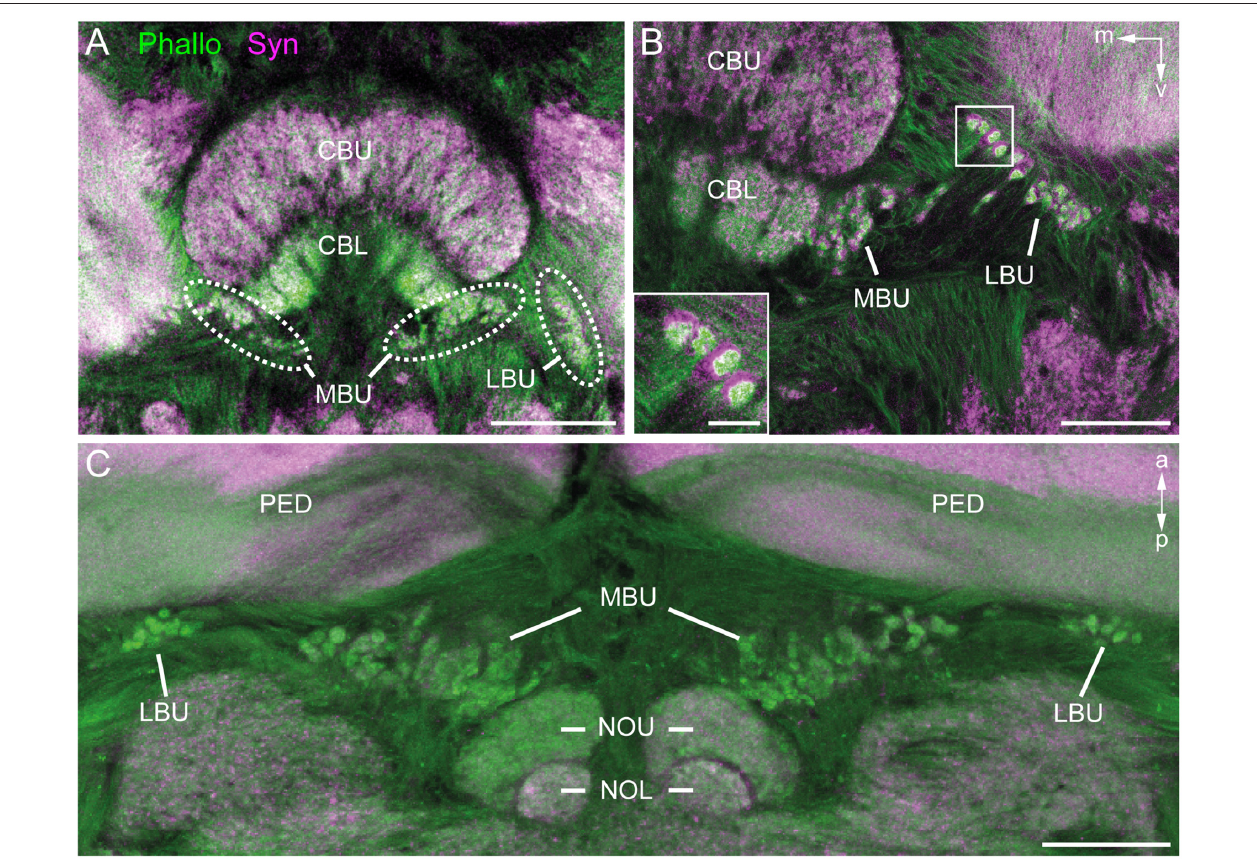
FIGURE 2 | Anti-synapsin (Syn, magenta) and f-actin phalloidin (Phallo, green) staining of the microglomerular synaptic complexes. (A) Frontal sections show that the synaptic complexes are arranged in two clusters: one in the MBU close to the connection of the CBL and the upper division (CBU). The second cluster is located in the LBU. (B) At higher magnification of both clusters the distribution of the anti-synapsin and f-actin phalloidin staining reveals a synapsin-positive cup-shaped structure with an f-actin containing profile in the center. (C) In horizontal sections the distribution in the anterior-posterior axis becomes apparent. The synaptic complexes in both bulbs appear posterior to the pedunculi (PED). Those of the MBU extend posterior to the upper division of the noduli (NOU). a, anterior; m, medial; NOL, lower division of the noduli; p, posterior; v, ventral. Scale bars: A = 100 µ m, B,C = 50 µ m, inset in B = 10 µ